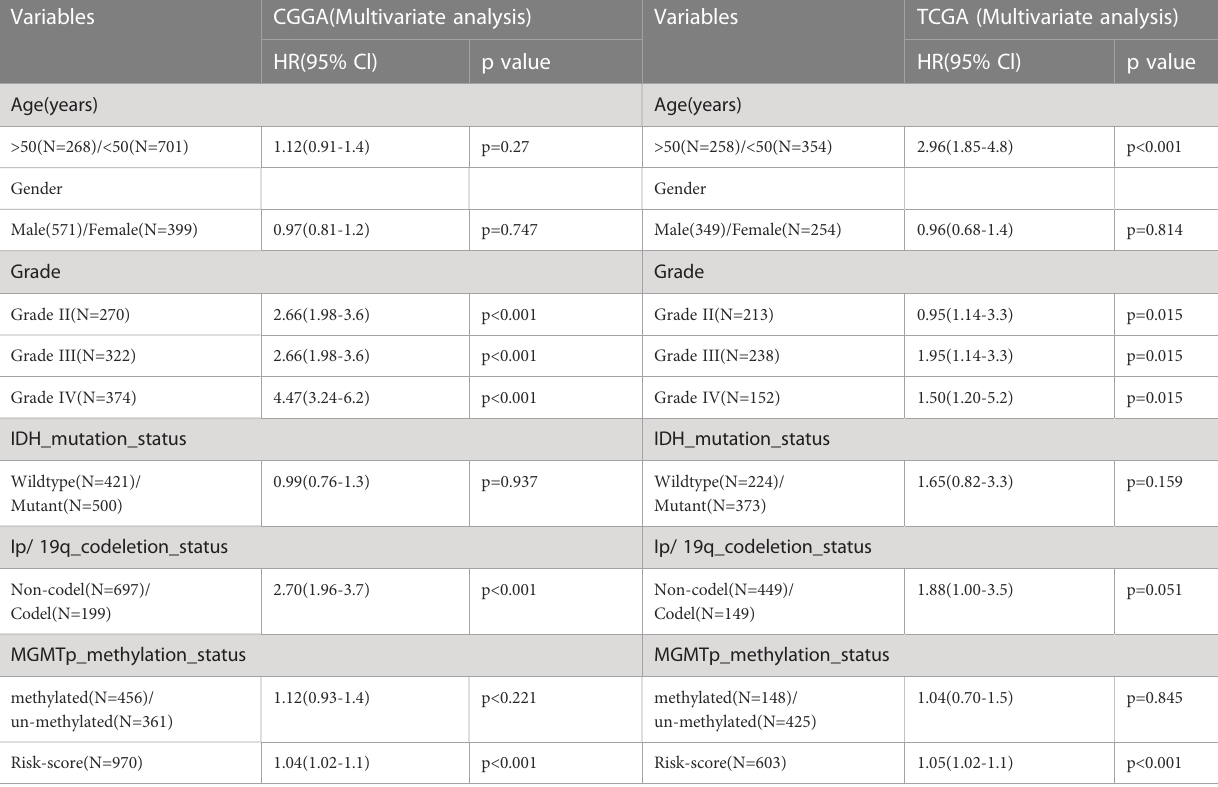
TABLE 1 Multifactorial analysis of risk-score and common clinically